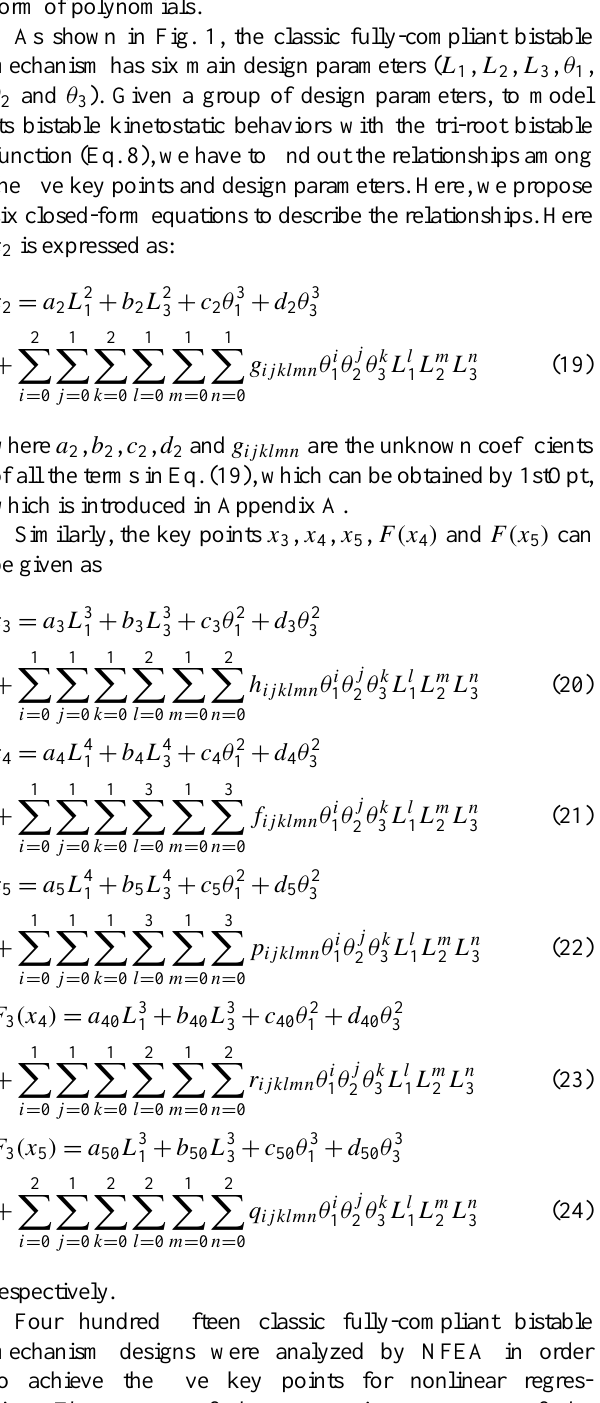
Table 4. Design parameters of the fully-compliant statically- balanced mechanism. H is the out-of-plane thickness of the mech- anism, E is the Young’s modulus of polypropylene. Part A of Part B of Balancing Parameter Tristable Tristable Bistable Mechanism